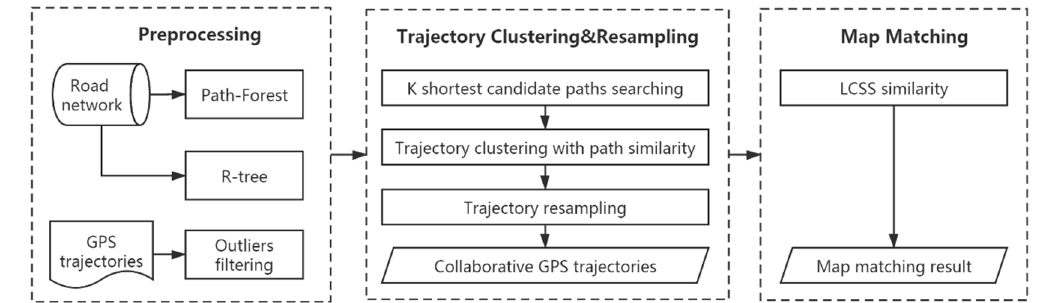
Figure 3. The framework of CMM algorithm.